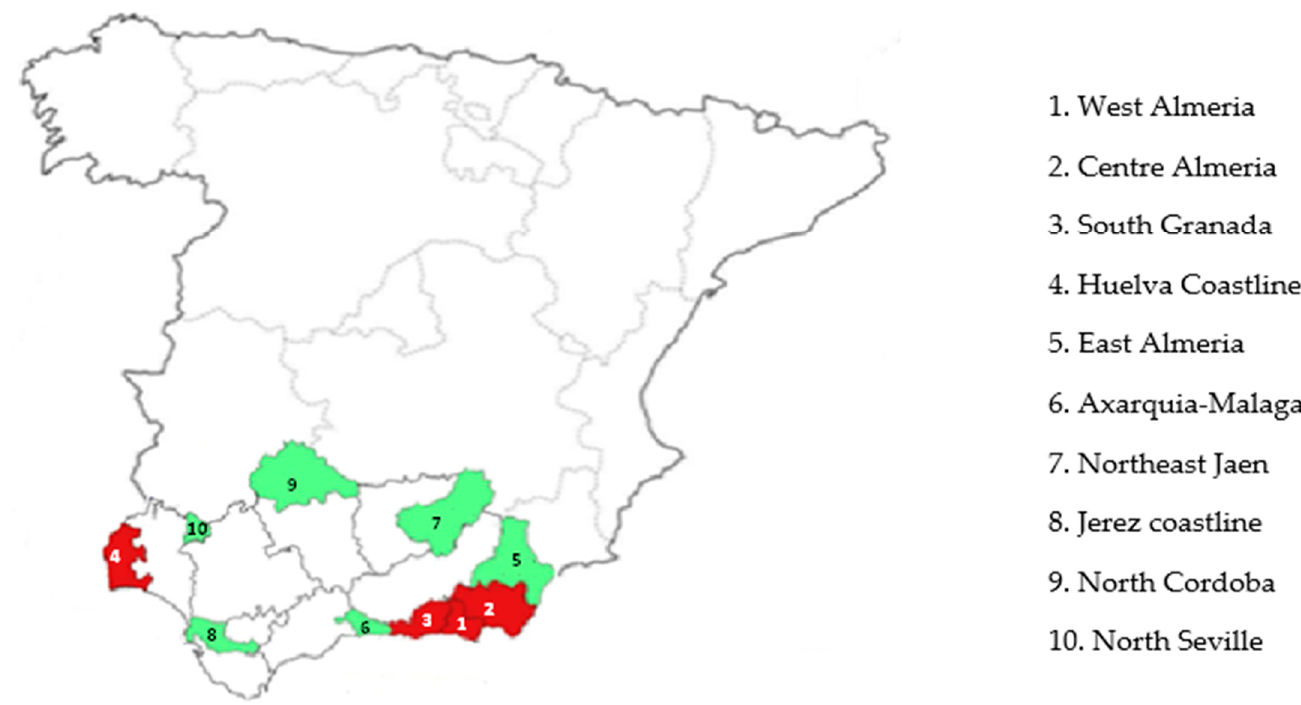
Figure 1. Geographic distribution of the study areas: high use of pesticides (dark red) and low use of pesticides (clear green).